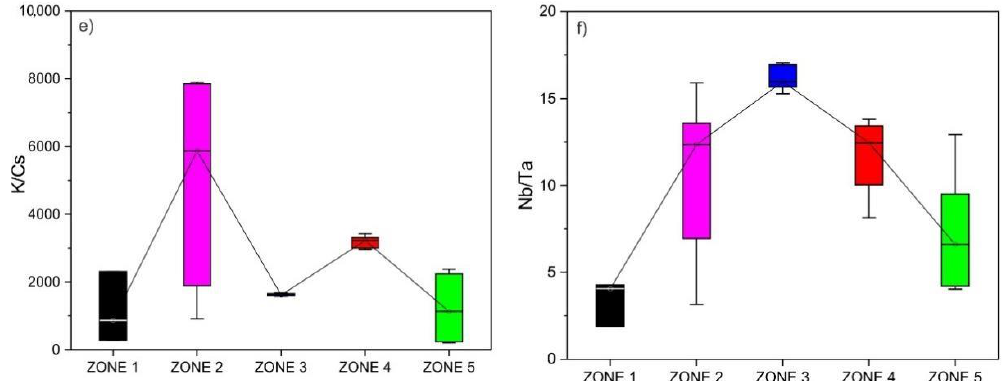
Figure 12. Plots of ( a ) K/Rb vs. Cs (ppm); ( b ) K/Rb vs. Be (ppm); Box and whisker plots of ( c ) Be;